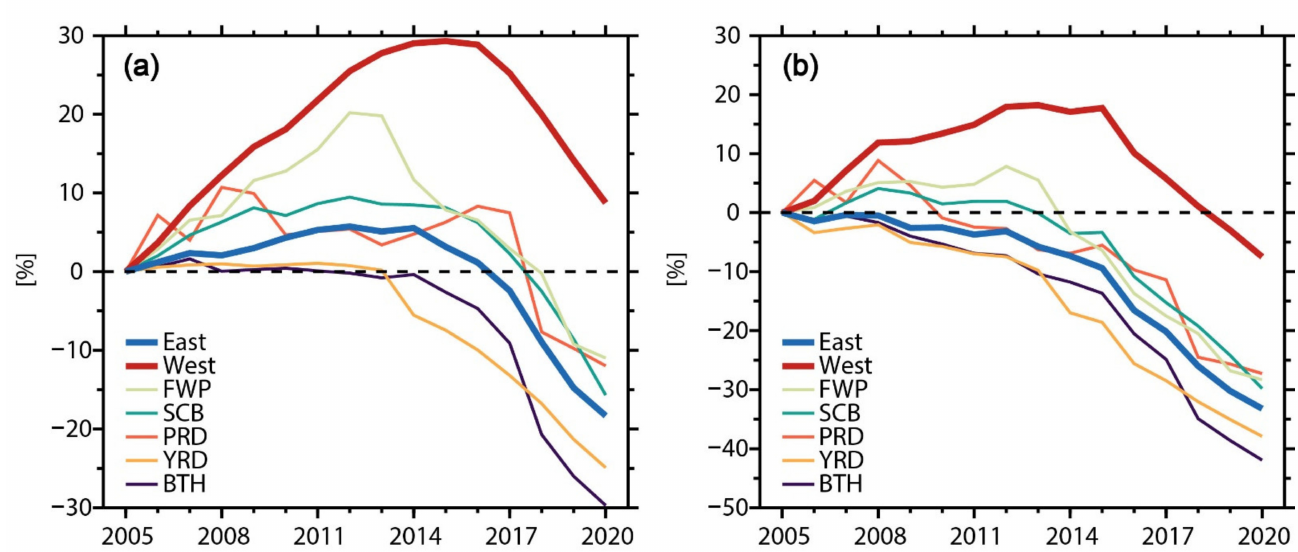
Figure 5. The relative changes of ( a ) synthetic nitrogen fertilizer application and ( b ) resulting NH 3 emissions in western China (bold red line), eastern China (bold blue line), FWP (Fengwei Plain, light green line), SCB (Sichuan Basin, dark green line), PRD (Pearl River Delta, orange line), YRD (Yangtze River Delta, yellow line) and BTH (Beijing–Tianjin–Hebei, purple line) from 2005 to 2020 with 2005 as a base year. The black dashed lines are zero